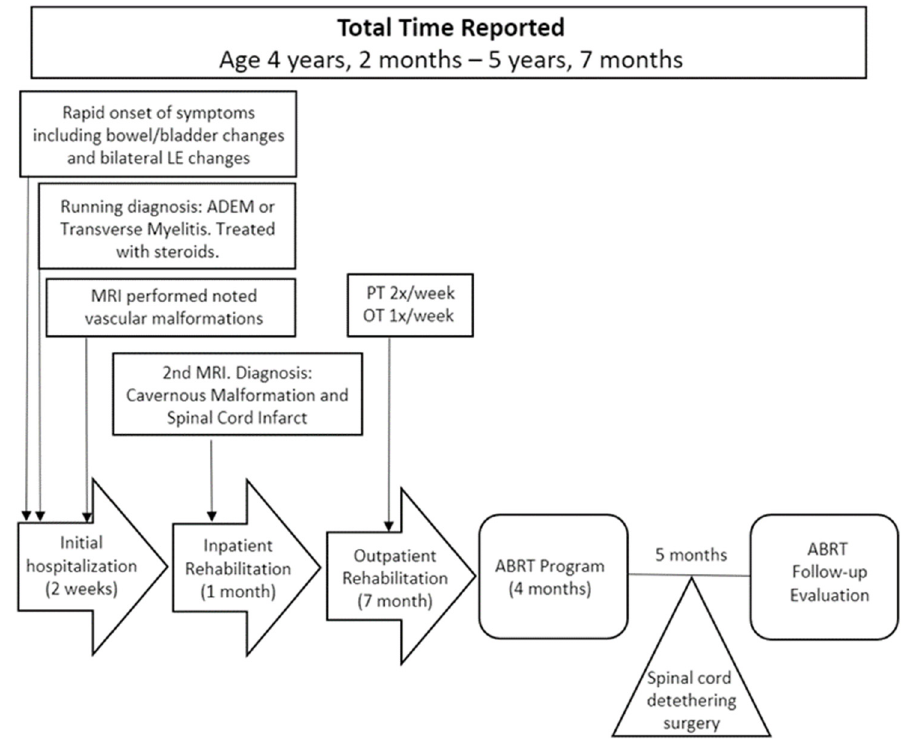
Figure 1. Timeline of medical history from injury (4 years, 2 months) through ABRT follow ‐ up eval ‐ uation (5 years, 7 months). LE = lower extremity, ADEM = Acute disseminated encephalomyelitis, MRI = Magnetic resonance imaging, PT = physical therapy, OT = occupational therapy, ABRT = ac ‐ tivity ‐ based restorative therapies.